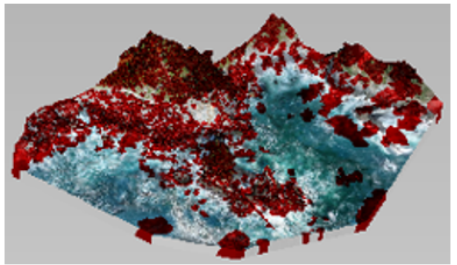
Figure 10. Mesh correction of the 3D rock model.